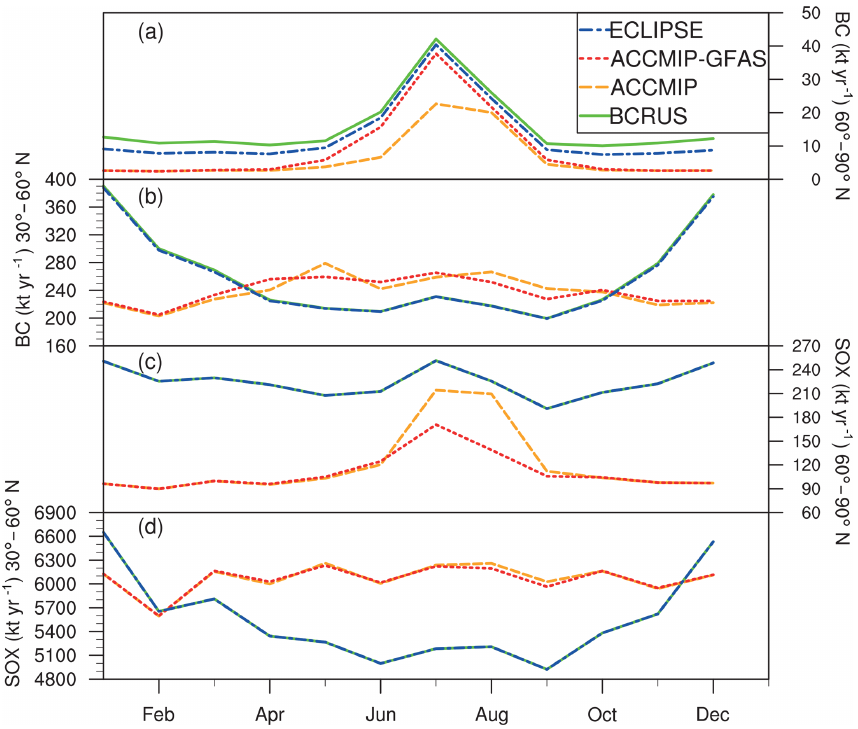
Figure 2. Multi-year monthly mean emissions of (a, b) BC and (c, d) SO X (SO 2 plus SO 4 ) for the years 2005–2015. Values are integrated over the latitude band between 60 and 90 ◦ N and between 30 and 60 ◦